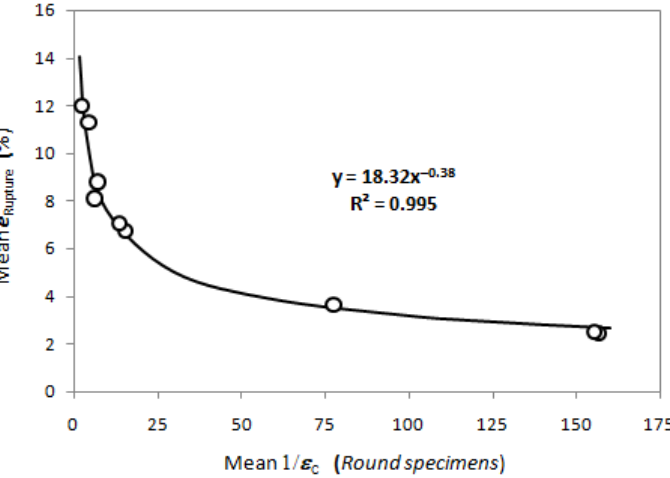
Figure 17. Mean 1/ ε c vs. mean elongation to rupture e Rupture (%) for any Ni content (0.0, 0.7 and 1.5 wt%) and austempering conditions (380 °C for 1 h; 310 for 3 h; 250 °C for 6 h) for the round specimens from the 25 mm Y-block ADIs.